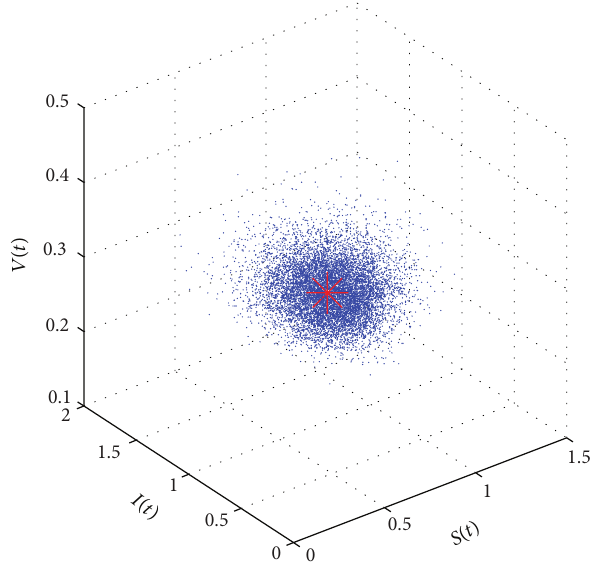
Figure 3: Population distribution around point 𝑃 ∗ (𝑆 ∗ ,𝐼 ∗ ,𝑉 ∗ ) = (0.75, 0.98, 0.275) (red point) corresponding to Figure